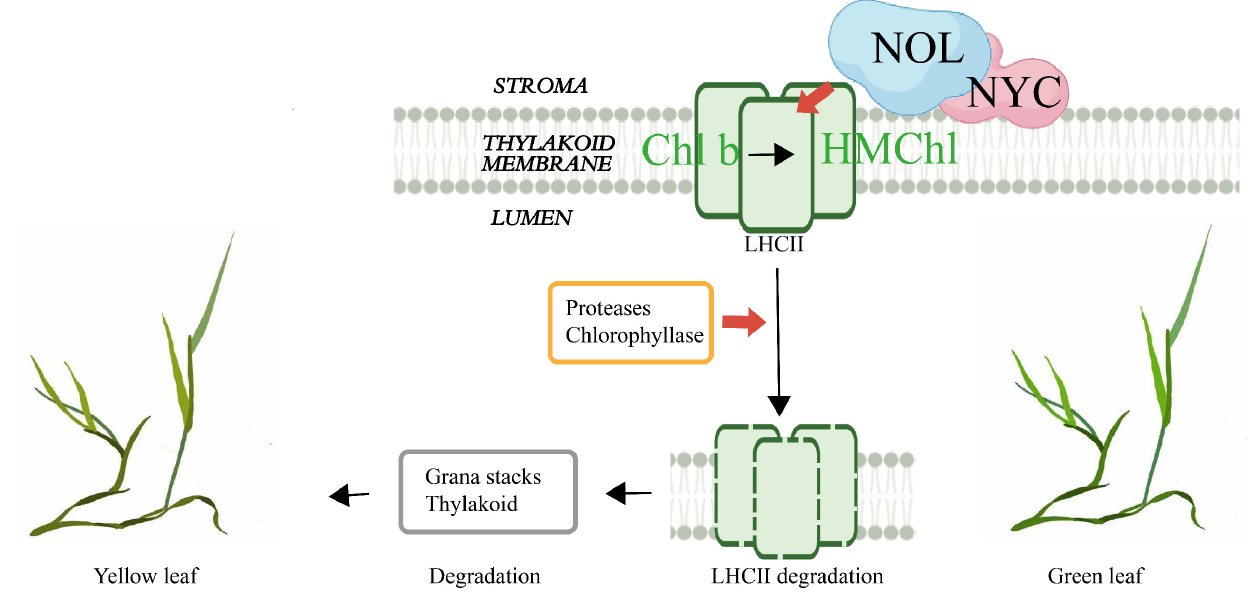
Figure 14. NOL regulates the degradation of chlorophyll and LHCII during leaf senescence [10]. Although the promoter element analysis revealed that the ZjNOL promoter contains cis-elements linked with ABA, IAA, GA, MeJA, and SA, the hormone content analysis revealed no significant variation in ABA and GA 7 content between the transgenic and control plants. The IAA and SA concentrations were substantially greater in the transgenic plants than in the control, while MeJA concentrations were significantly lower in transgenic plants. To investigate the effect of ZjNOL ectopic expression on leaf color, we examined the effect of darkness treatment on the expression of the AsZDS , AsNCED , AsCLH , and AsNYC genes. AtZDS regulates the catalytic impact of Z-carotene on tetracis-lycopene and is also a key gene for carotenoids synthesis [15]. AsNCED , a carotene lyase, is a critical enzyme for stress-induced ABA biosynthesis [16]. AsCLH catalyzes the ester bond hydrolysis of chlorophyll and chlorophyl, the initial step in the breakdown of chlorophyll [14]. AsNYC participates in the breakdown of the LHCII [6]. The relative expression of AsCLH1 between the control and OE plants have similar trends on different days. Conversely, the trends of overexpression of AsZDS, AsNCED, and AsNYC are predominantly distinct with the control plants. The impact of ectopic expression of ZjNOL on plant leaf color may be due to a variety of biological processes, not just chlorophyll. Fewer differentially expressed genes were filtered out in the transcriptome, which may be attributable to the fact that the plant samples for transcriptome analysis had not yet passed the senescence stage. This shows that NOL performs a major regulatory function exclusively in mature leaves, which is congruent with the findings of expression pattern analysis. Even yet, numerous genes associated with chlorophyll degradation were screened by transcriptome sequencing, and DIN1 and LARS ( leucine tRNA ligase ) were considerably up-regulated in transgenic plants. Mt-nd4 ( NADH-ubiquinone oxidoreductase chain 4 ) and PPH ( pheophytinase ) were dramatically down-regulated. DIN1 is a dark-induced senescence-related gene encoding the synthesis of senily-associated protein DIN1. DIN1 encoded peptides may be imported by isolated chloroplasts and subsequently localized to the stromal fraction in Raphanus sativus , and it was thought to be the first gene producing a chloroplast protein that is negatively